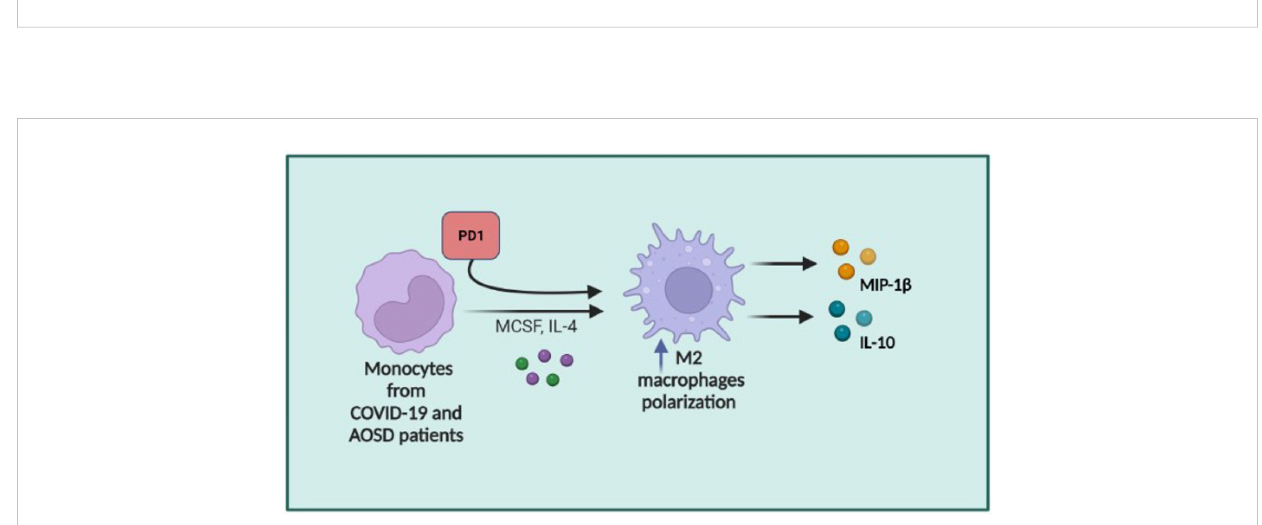
FIGURE 6 Summary of the in vitro experiments. In vitro PD1 induced the differentiation of monocytes from patients with both AOSD and COVID-19 in M2- macrophages and their secretion of IL-10 and MIP-1 b (Created with